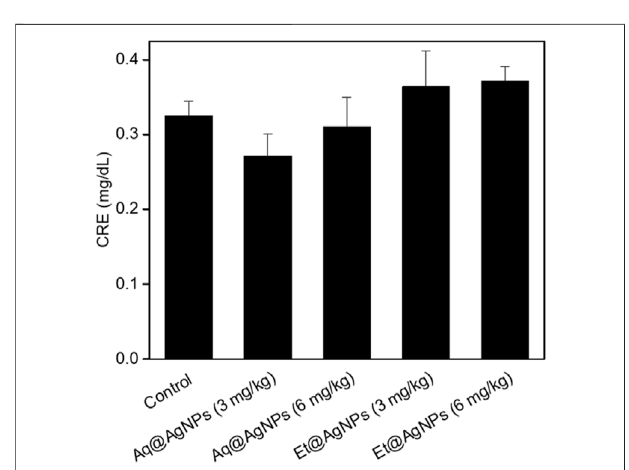
FIGURE 7 | Kidney function biomarker of bAgNPs-treated rats. Serum creatinine (CRE) was measured as a liver function biomarker. Two different doses (i.e., 3 and 6 mg/kg) of both Aq@AgNPs and Et@AgNPs were injected through intravenous route. No signi fi cant difference was observed in One-wayANOVA test when treatment groups werecompared withthatofthe control and p > 0.05.